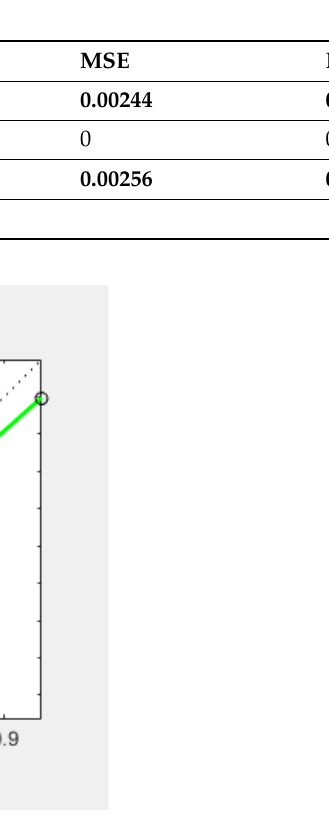
Figure 4. Output results of the ANN model. R 2 = 0.90563. Output = 0.9 × Target + 0.049.